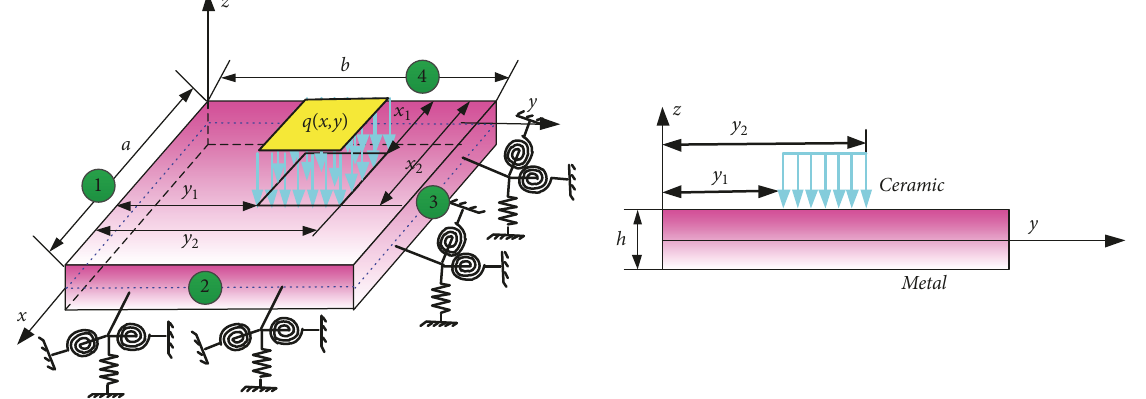
Figure 1: Schematic diagram of a FG Mindlin plate with elastically restrained edges.